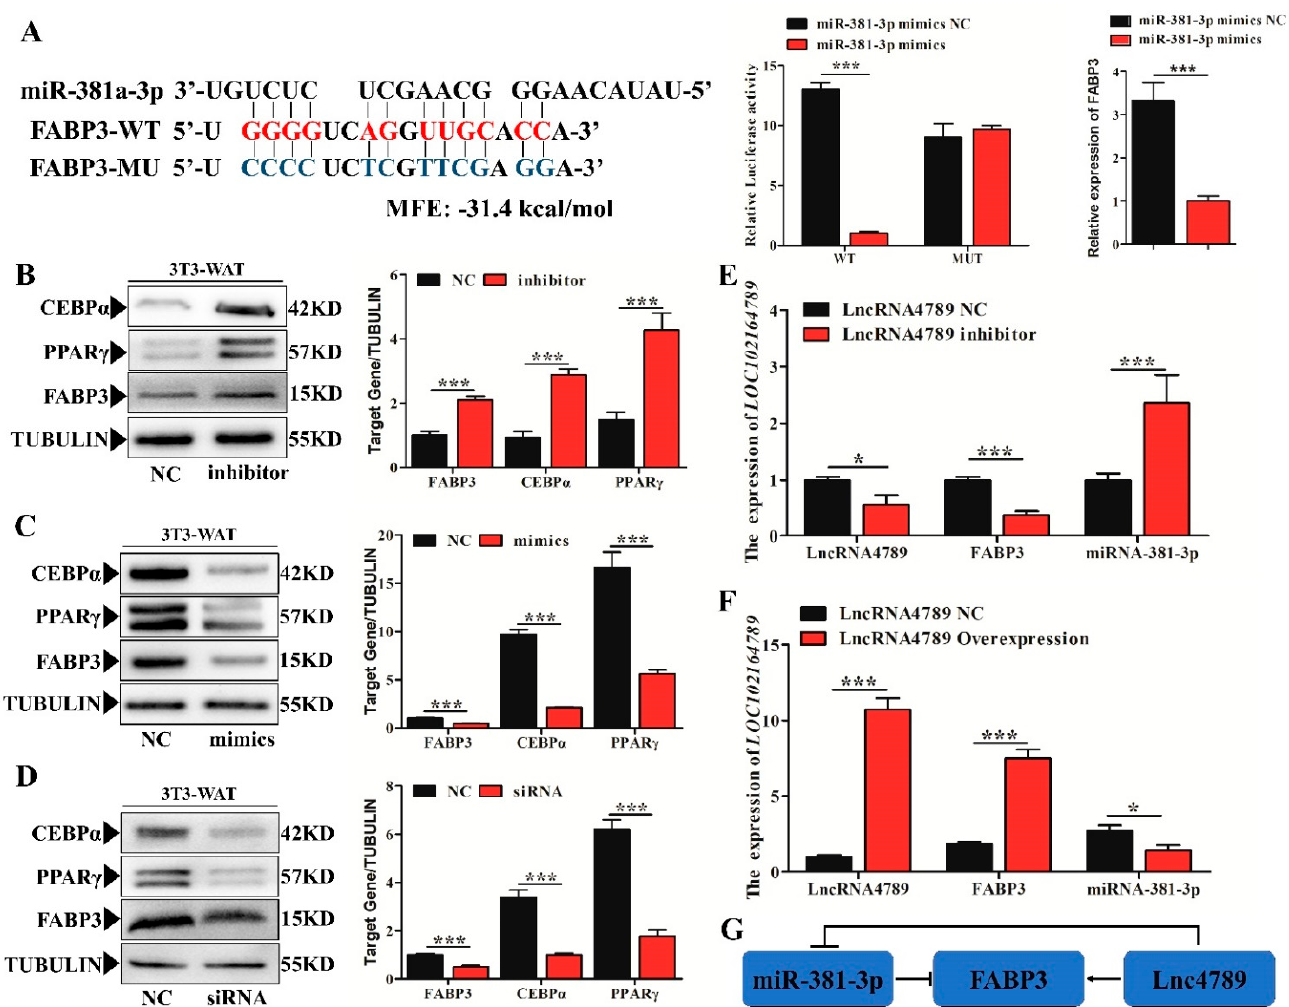
Figure 5. Verification of miR-381-3p target binding for FABP3 3 ′ UTR while lncRNA4789 released the expression of FABP3 by ceRNA. ( A ) Left histogram: Prediction of binding sites between miR-381-3p and FABP3 in RNAhybrid. Right histogram: left panel showed luciferase assays were performed in 293-Tcells co-transfected with pMirGLO- FABP3 –3 ′ -UTR-WT/MUT and ssc-miRNA-381-3p mimics while right panel showed FABP3 mRNA expression detected in adipocyte after treatment with ssc- miRNA-381-3p mimics. Red letters indicate wild type sites and blue letters indicate mutated sites in the pMir-report luciferase reporter vector; protein expression levels of PPAR γ , C/EBP α and FABP3 between NC and miR-381-3p inhibitor; ( B ) miR-381-3p mimics ( C ) and FABP3 -siRNA; ( D ) mRNA expression of FABP3 and miR-381-3p under lncRNA4789 overexpression ( E ) and the presence of an inhibitor ( F ); ( G ) ceRNA regulation mechanism in miRNA-381-3p , FABP3 and lncRNA4789 . Error bars indicate the mean ± SD of triplicate experiments; * p < 0.05, *** p < 0.001; MFE, minimum free energy.